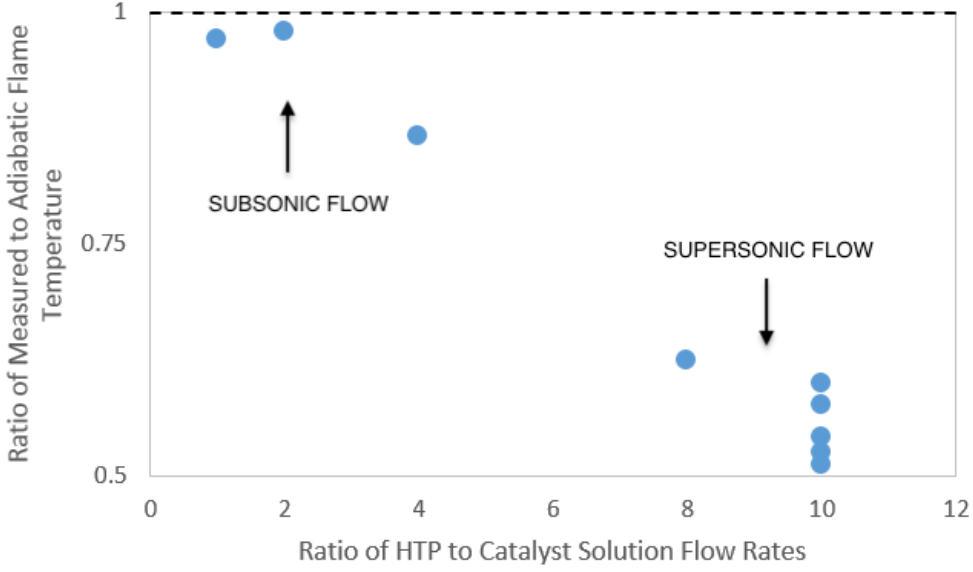
Figure 19. The ratio of measured to adiabatic flame temperature vs. the ratio of volumetric flow rate of HTP to catalyst solution. These data strongly suggest that, at low ratios of HTP to catalyst solution, flow is not choked at the nozzle throat and remains in the subsonic regime throughout the